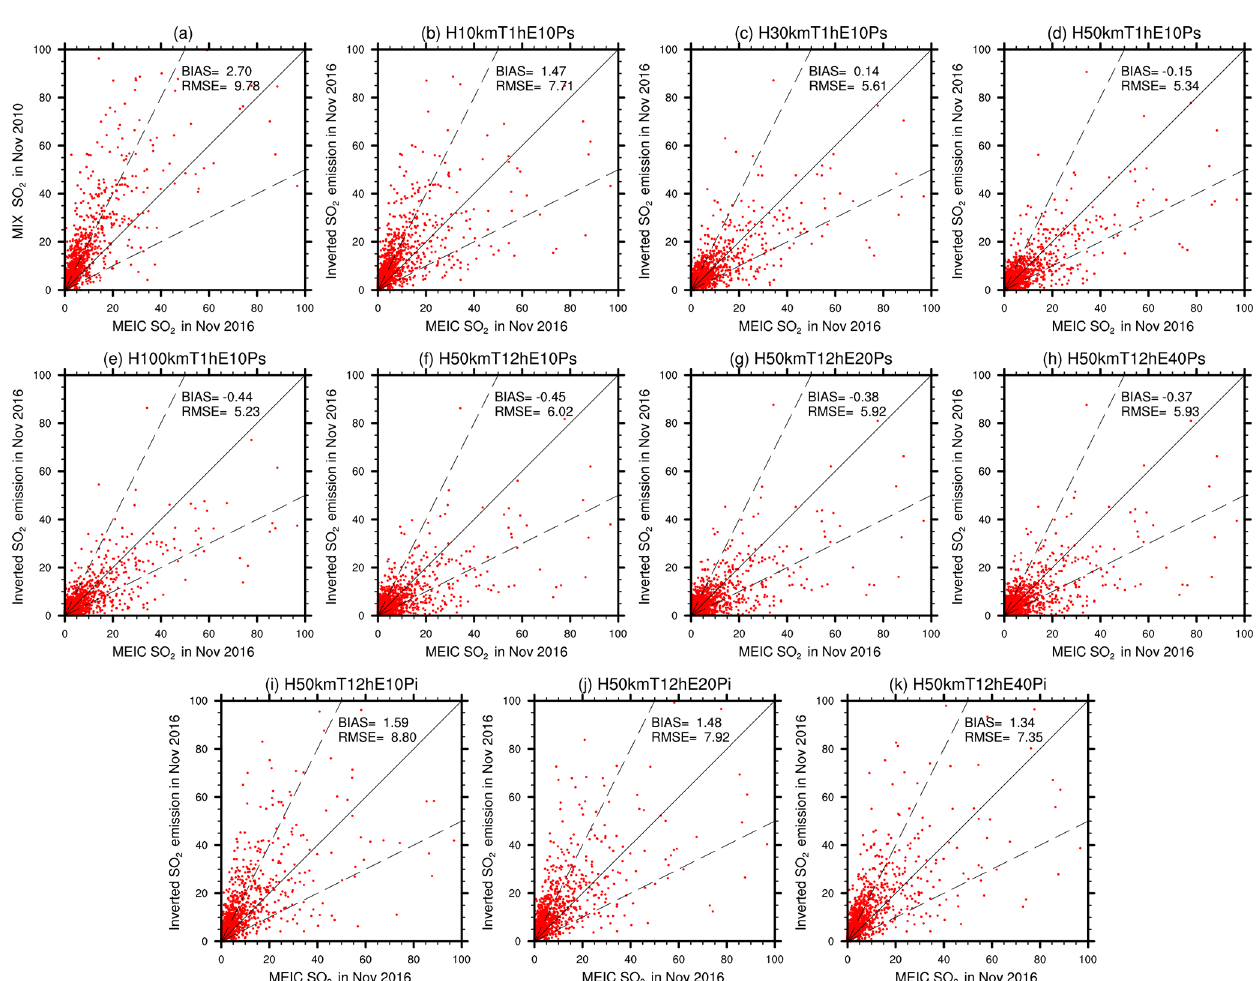
Figure 4. Comparisons of the MIX SO 2 emissions in November 2010 (a) and the inverted SO 2 emission in November 2016 in various data assimilation experiments (b–k) to the MEIC SO 2 emissions in November 2016.